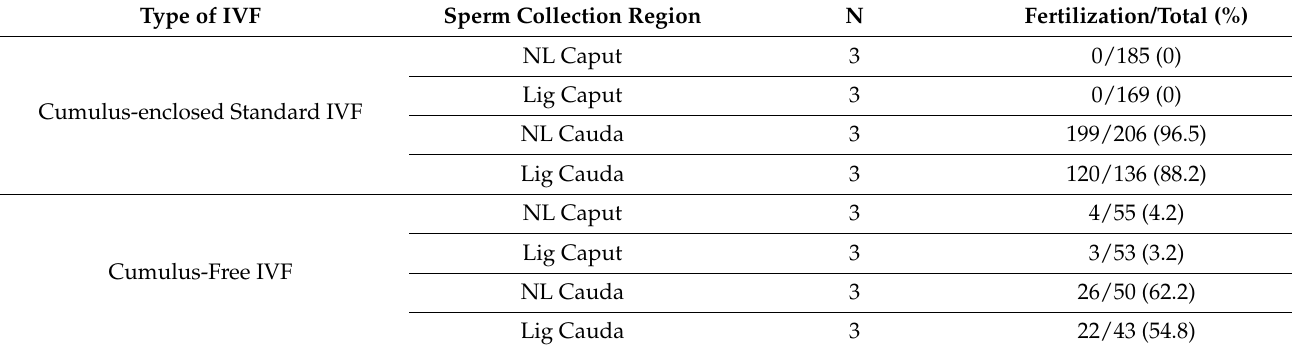
Table 1. Cumulus-enclosed Standard, Cumulus-Free and Zona-Free in vitro fertilization assays. Sperm samples were recovered from each experimental condition and placed into capacitation media. Cumulus-enclosed Standard IVF: samples were co-incubated with cumulus-oocyte-complexes (COCs) for 4 h, before removal from insemination droplet. Fertilization was evaluated 24 h later by visualization of 2-cell embryos. n = 3. Cumulus-Free IVF: prior to insemination, COCs were incubated with hyaluronidase to remove cumulus cells as described in methods. Samples were then co-incubated with MII-oocytes for 60 min, removed from the insemination droplet and fertilization was determined by visualization of 2-cell stage embryos. n = 3. Zona-Free IVF: prior to insemination, MII-oocytes were incubated with Tyrode’s acid to remove zona pellucida as described in methods. Samples were then co-incubated with MII-oocytes for 60 min, removed from the insemination droplet and fertilization was determined by visualization of 2-cell embryos. n = 9. Type of